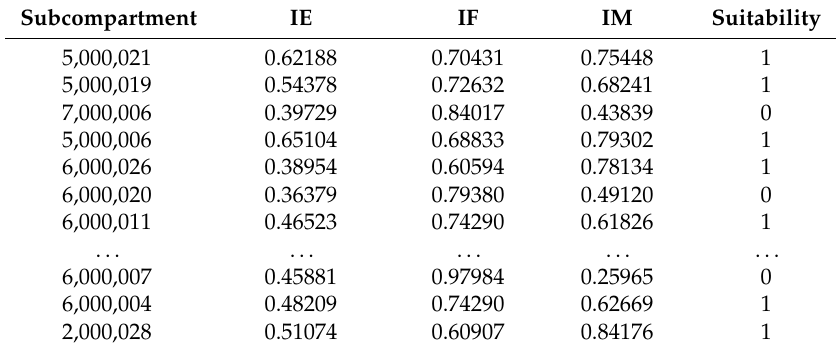
Table A2. Results of multifunctional suitability assessment. (IE—important index of ecological status; IF—Forest productivity index; IM—multifunctional forest site quality). Suitability is a binary type of data, 1 indicates suitability and 0-unsuitability for multifunctional operation.